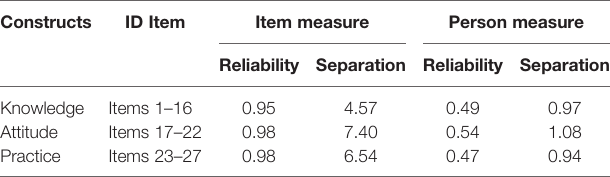
TABLE 2 | Reliability and separation indices for draft healthcare workers ’ knowledge, attitudes, and practices instrument for uncomplicated malaria containing 27 items using Rasch model (N =